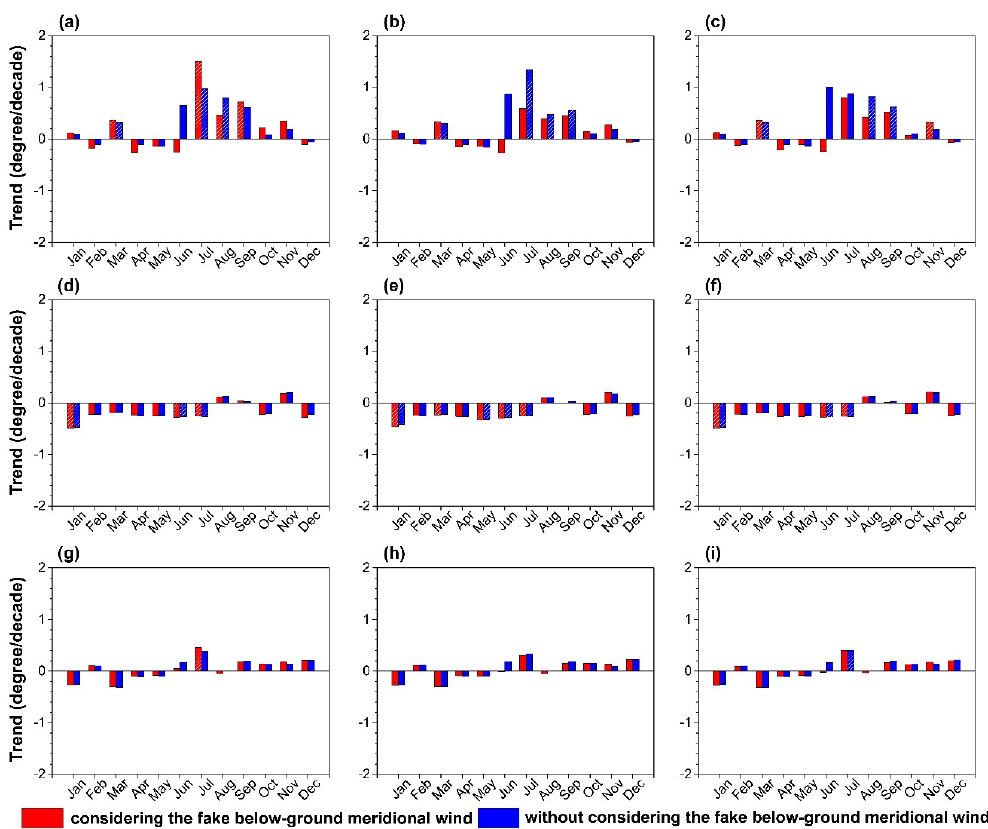
Figure 13. ( a – c ) Annual cycle of the linear trends of the NE from 1979–2018 derived from ( a ) M1, ( b ) M2, and ( c ) M3 using the MRM data sets. The trends that passed the 95% statistical confidence level are filled with oblique lines. The red and blue bars are for the results that considered and did not consider FBGMW, respectively. ( d – f ) and ( g – i ) same as ( a – c ) but for the SE and CE, respectively. The units for the trends are degree/decade.